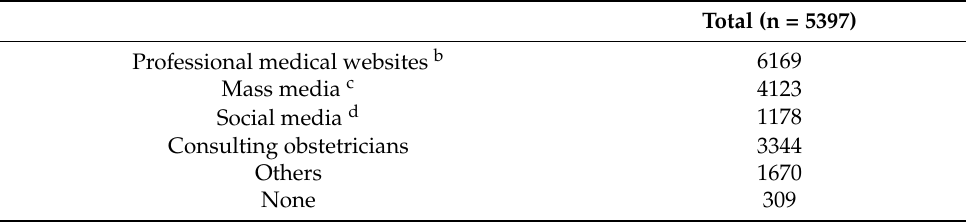
Table 2. Websites used by participants to obtain information on COVID-19 and vaccines a .